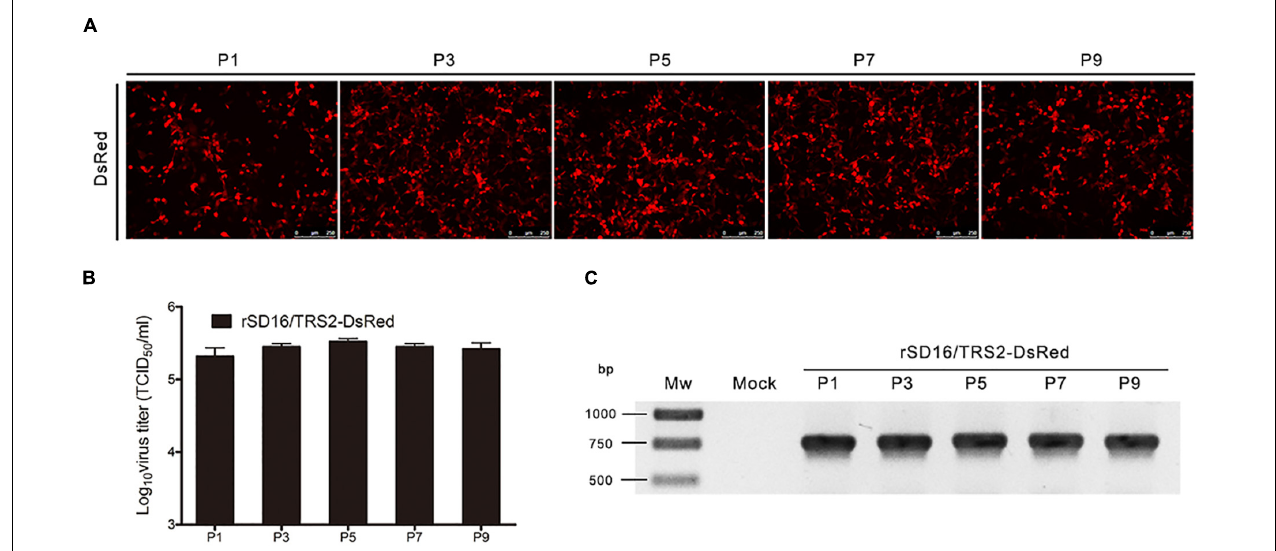
FIGURE 3 | Stable expression of DsRed in different passages of rSD16/TRS2-DsRed. (A) In different passages, fluorescence pictures of the recombinant virus were captured at 48 hpi by fluorescence microscopy; (B) titers of the recombinant virus were detected at different passages by TCID 50 method, all the tests were repeated three times; (C) mRNA production of DsRed gene at different passages of the recombinant virus were detected by reverse transcription PCR